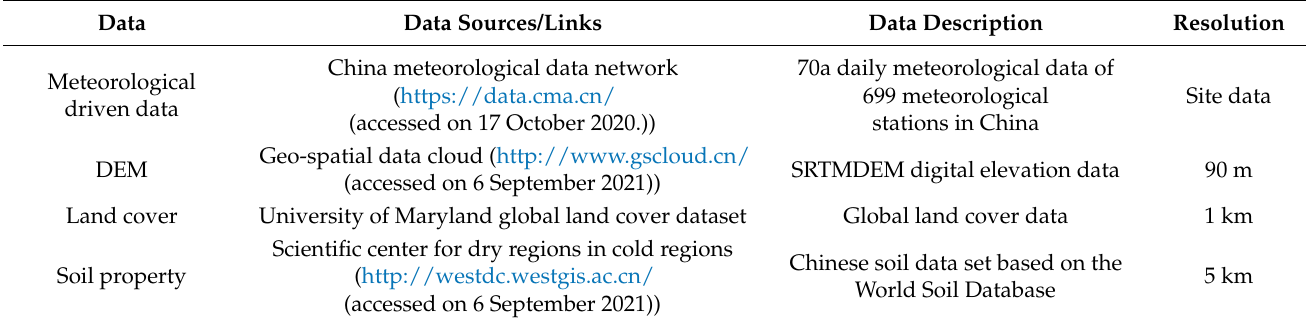
Table 1. Summary of input data for driving the VIC